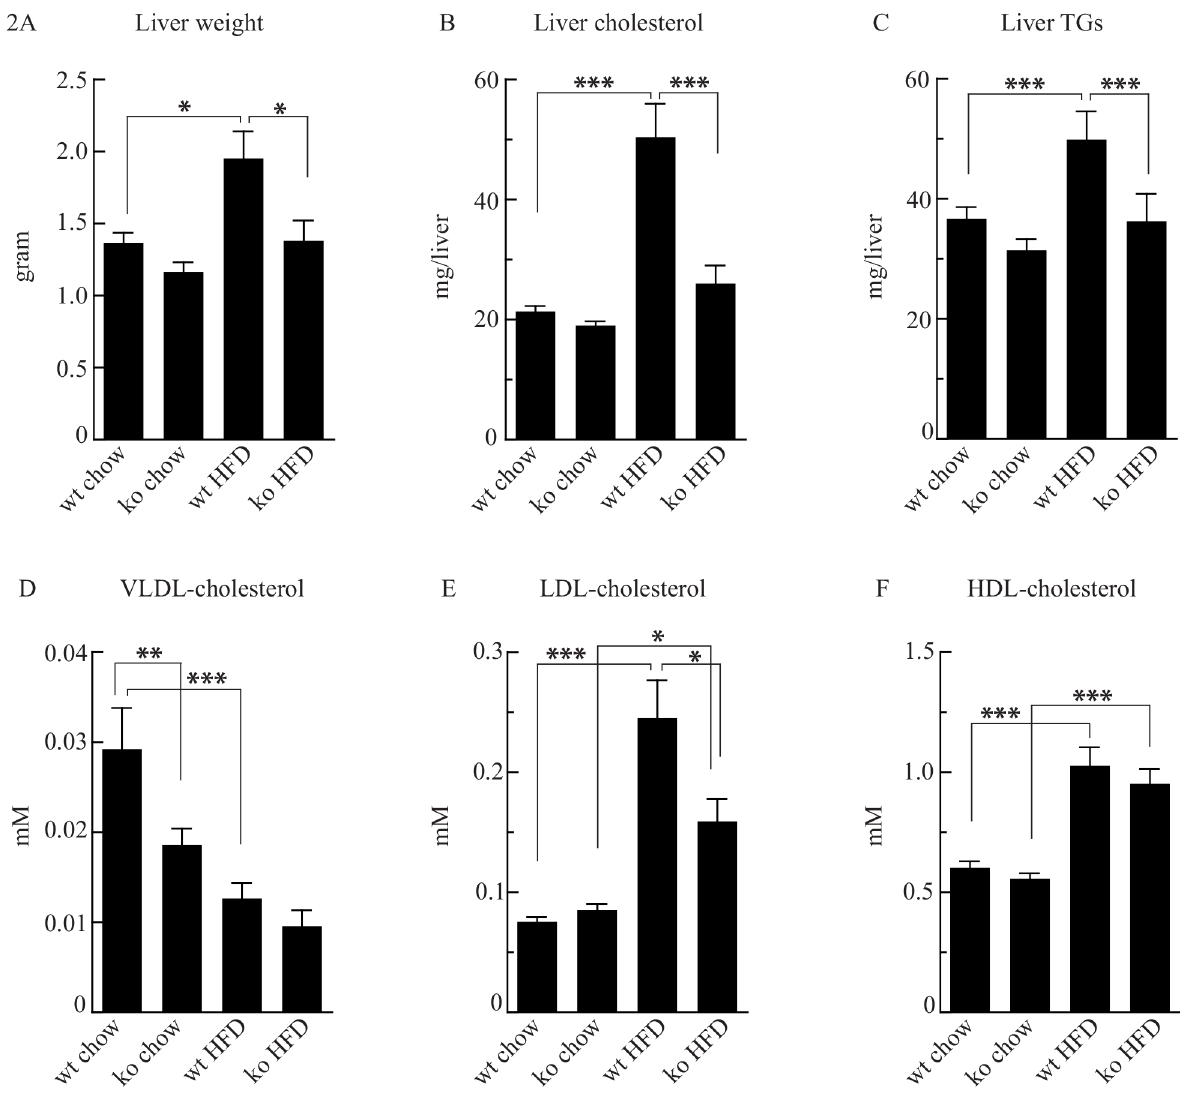
Fig 2. Cyp8b1 -/- (ko) mice are protected from liver hypertrophy and fatty liver when exposed to high fat diet (HFD) and display improved lipoprotein profiles as compared to Cyp8b1 +/+ (wt) mice. Liver weight (A) , liver cholesterol (B) and liver triglycerides (TGs) (C) . Serum cholesterol in VLDL (C) , LDL (D) , and HDL (E) lipoprotein fractions. Data is shown as mean ± SEM, n = (18 – 19) for all groups. *** = p < 0.001, ** = p < 0.01, and * = p <